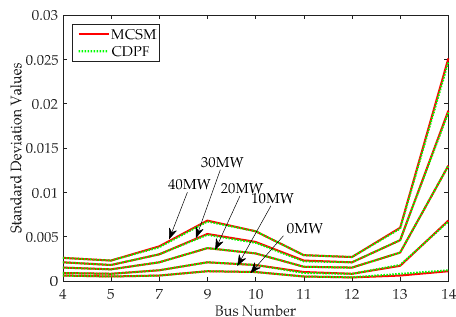
Figure 8. The standard deviations of the voltage magnitude at PQ buses with the rated power of the FCG at bus-14 being 0 MW, 10 MW, 20 MW, 30 MW and 40 MW, respectively, in an IEEE 14-bus power system.